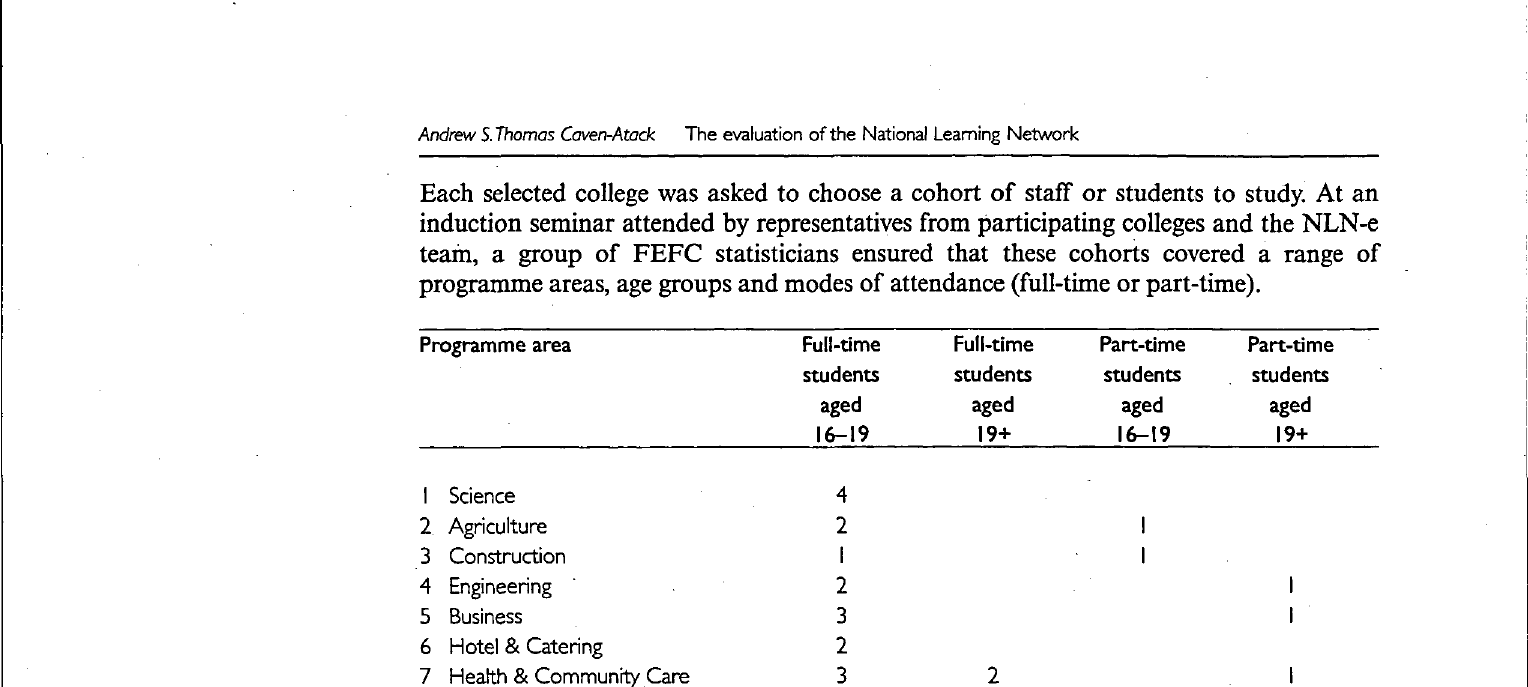
Table I: Cohorts being studied within each FEFC programme area, across age ranges and modes of attendance. (One cohort is across college and